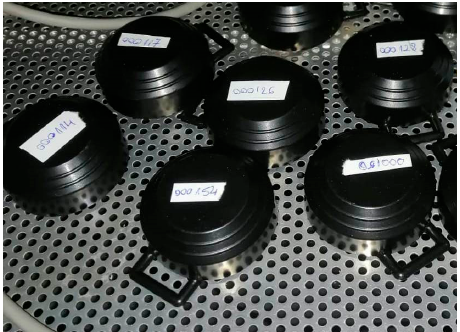
Figure 2. The plastic capsules containing TASTRAK detectors, in the IFIN-HH radon chamber. The optical system TASLIMAGE reads an area of 1 cm 2 in the center of each detector.